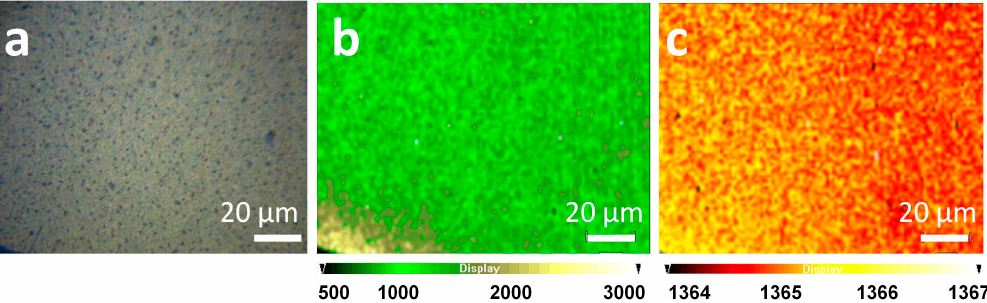
Figure 6. SERS images of rhodamine 6G at the substrate after 8 min of UV-illumination: optical microscopy image of substrate ( a ); and Raman maps of ~1365 cm − 1 band: intensity ( b ); and position ( c ).